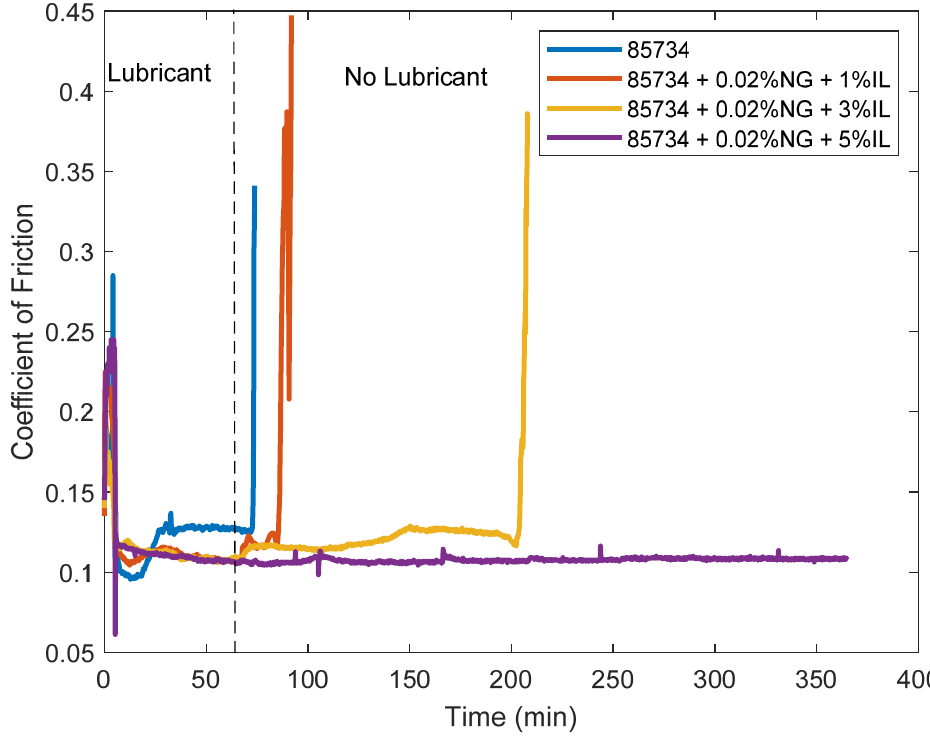
Figure 7. Coe ffi cient of friction during reciprocating pin-on-flat, loss-of-lubrication experiments. The dotted line shows the time of lubricant removal.